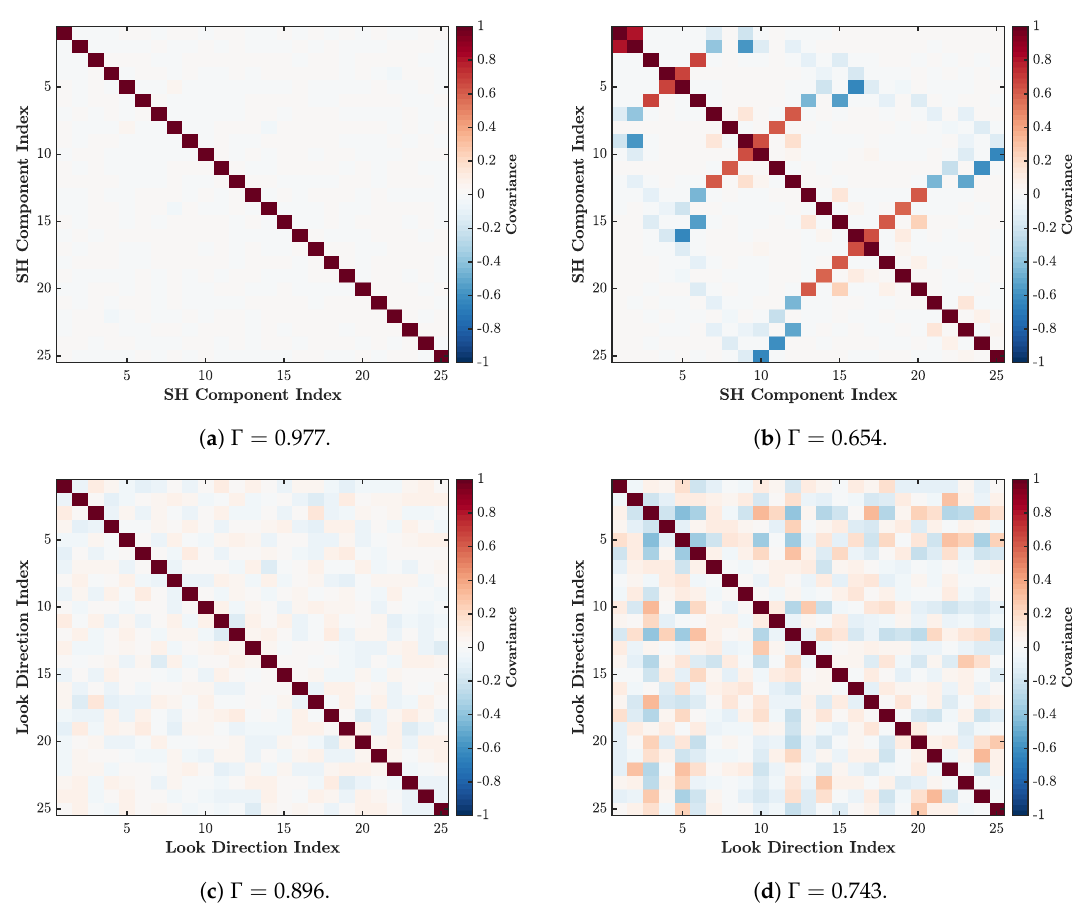
Figure 2. Covariance matrices in the spherical harmonic domain (top, ( a , b )) and PWD spatial domain (bottom, ( c , d )) for a fully isotropic field (left, ( a , c )) and an anisotropic field, synthesized using a cardioid directivity pattern with a 60-dB dynamic range (right, ( b , d